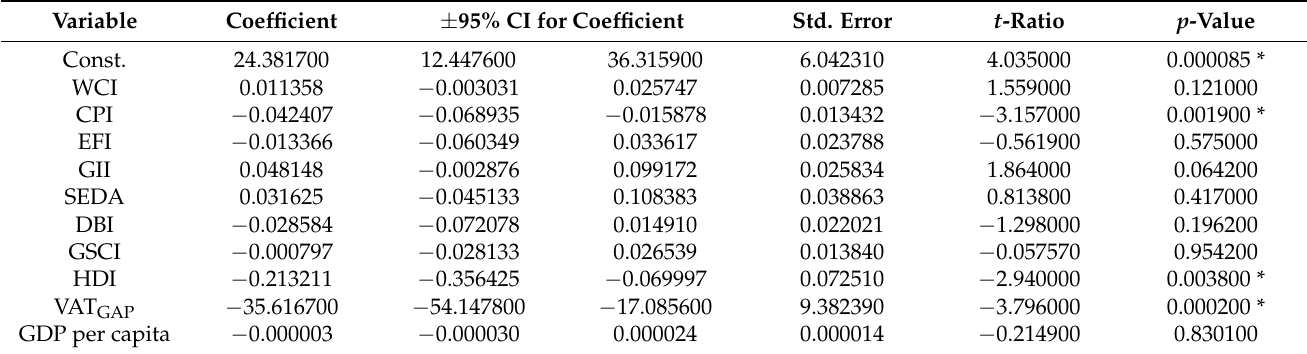
Table 2. The regression coefficients estimation of Fixed Effects Model for Basel AML index within EU destination